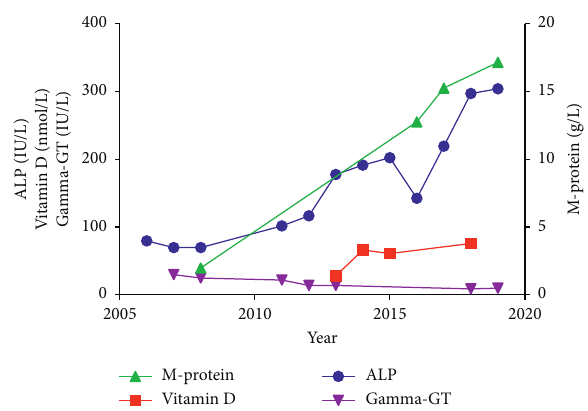
Figure 1: Changes in ALP, M-protein, vitamin D, and gamma-GT in the patient’s sera with